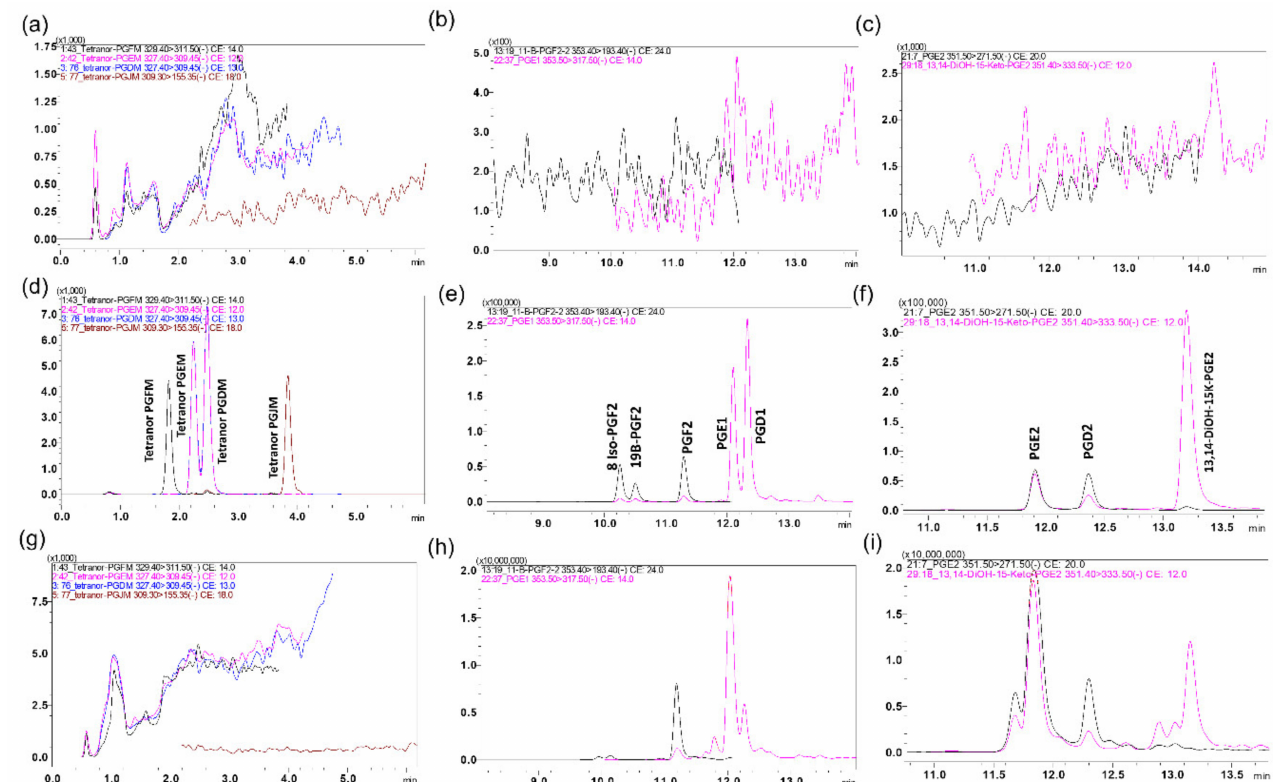
Figure 2. Representative overlaying multiple reaction monitoring (MRM) ion-chromatograms of isobaric eicosanoids that also share fragmentation patterns but were separated chromatographically: ( a – c ) blank charcoal-stripped surrogate matrix of selected analytes, ( d – f ) spiked in charcoal-stripped surrogate matrix of selected analytes (0.5 g/mL), and ( g – i ) healthy colon sample of selected